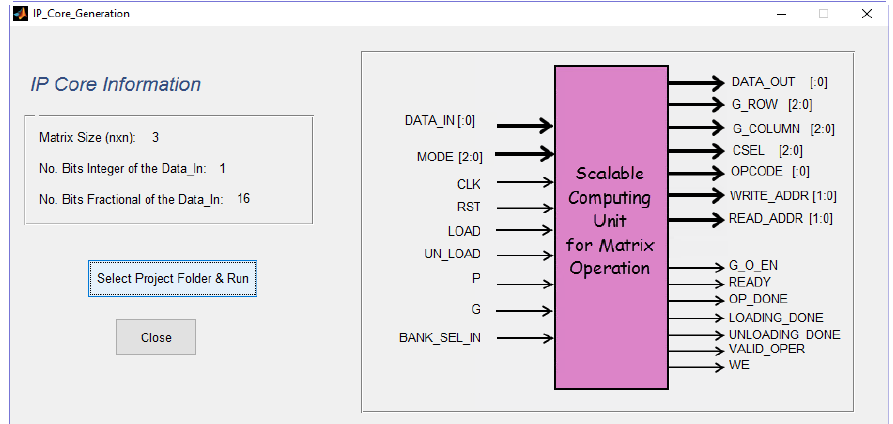
Figure 9. MATLAB GUI interface of the IP core generation option.